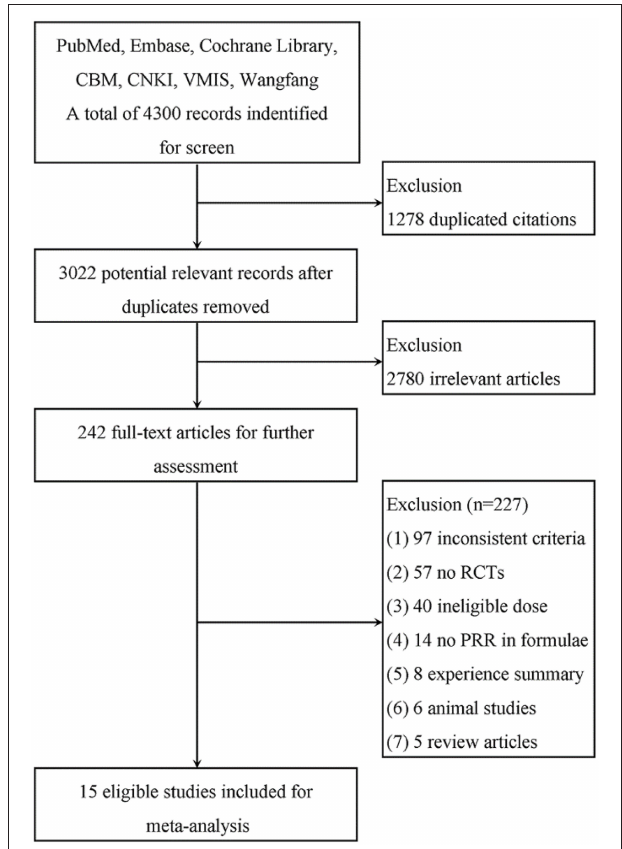
FIGURE 2 | Flow diagram of the study selection process for the systematic review. As shown, our initial searches yielded 4300 records. The full texts of 242 articles were retrieved for detailed assessment after exclusion. Of these, 227 studies were subsequently excluded because they did not meet the inclusion criteria; 15 eligible studies were